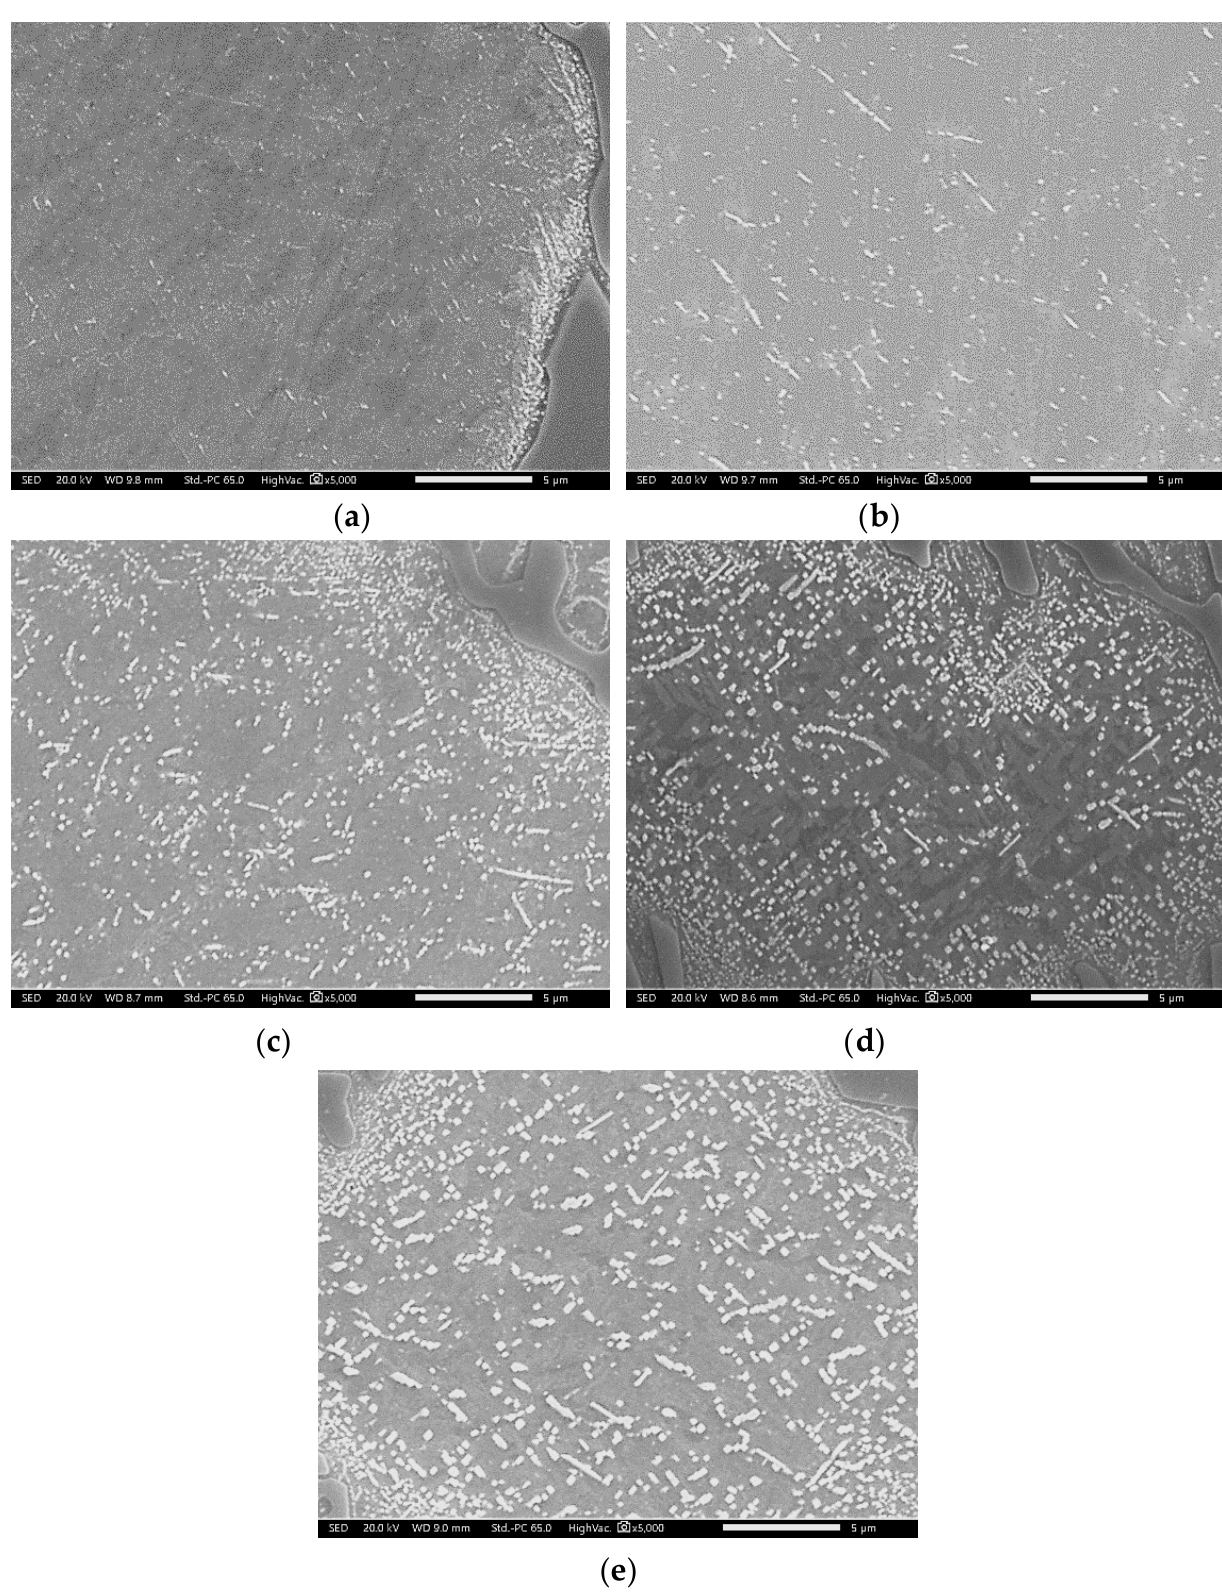
Figure 13. Gradual M 23 C 6 precipitation of 2124 alloy with time elapse at 850 °C: ( a ) 10 min; ( b ) 30 min; ( c ) 60 min; ( d ) 240 min; ( e ) 300 min.